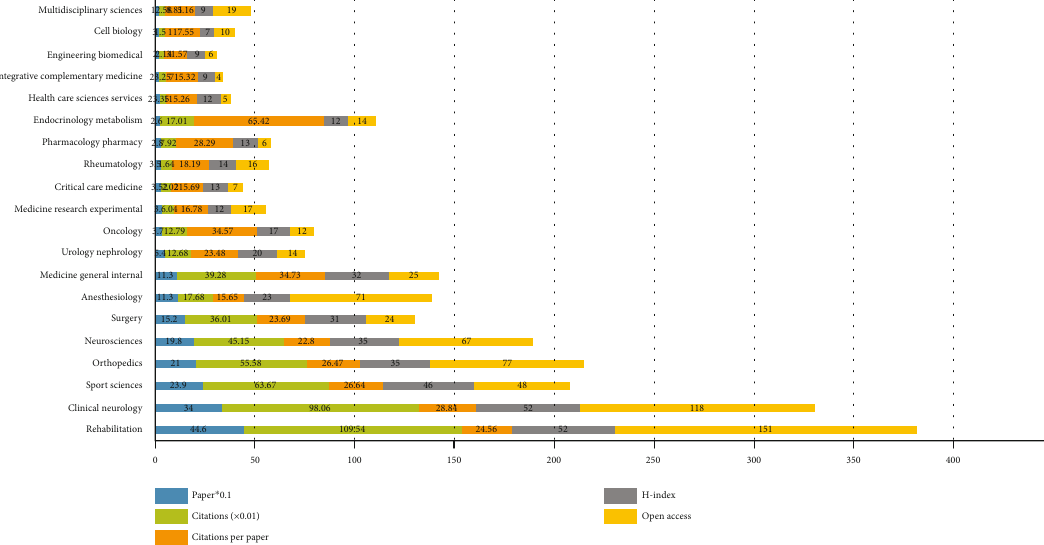
Figure 10: The number of papers, citations, citations per paper, open access papers, and H -index of the top 20 subject categories of the Web of